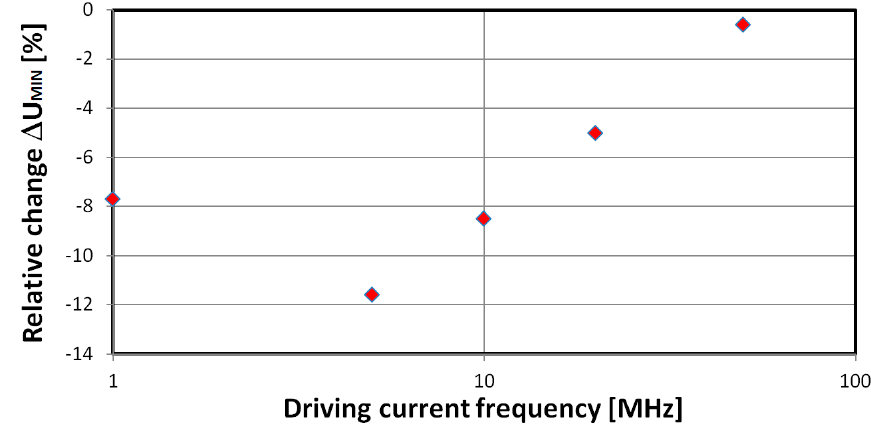
Figure 4. Measured HF voltage drop U signal for a 5 MHz, 400 mV RMS driving signal. The minimum of the voltage drop signal U min (corresponding to arrows in Figure 3b) is the strain-dependent part of the measured waveform.